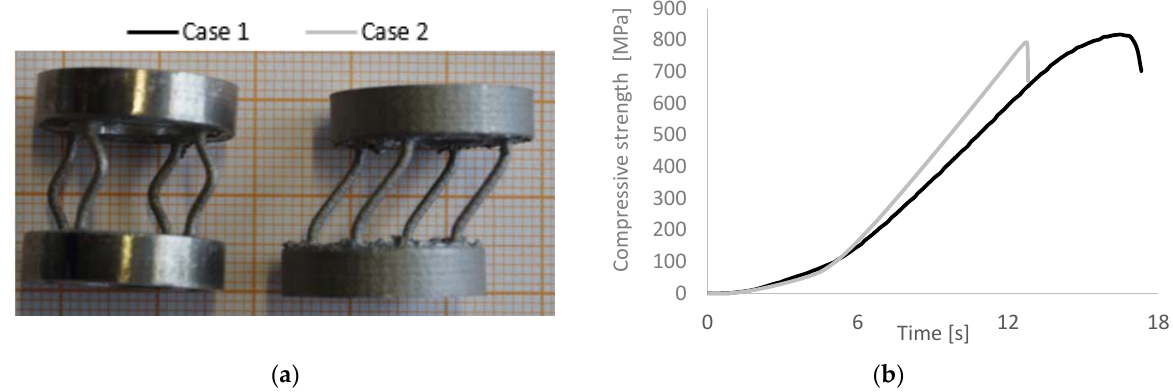
Figure 15. ( a ) Representative failure behavior of tested samples. Both samples show the same compression strength. ( b ) Strength–time curve representing the two kinds of failure behavior. Both samples exhibit the same compression strength. Table 5. Overview of the results from compression testing (compressive strength σ ; n = 5 for each design) for all geometrical variations taking account of the orientation and slenderness ratio λ . The diameter d and height L are defined by CAD. Dimension